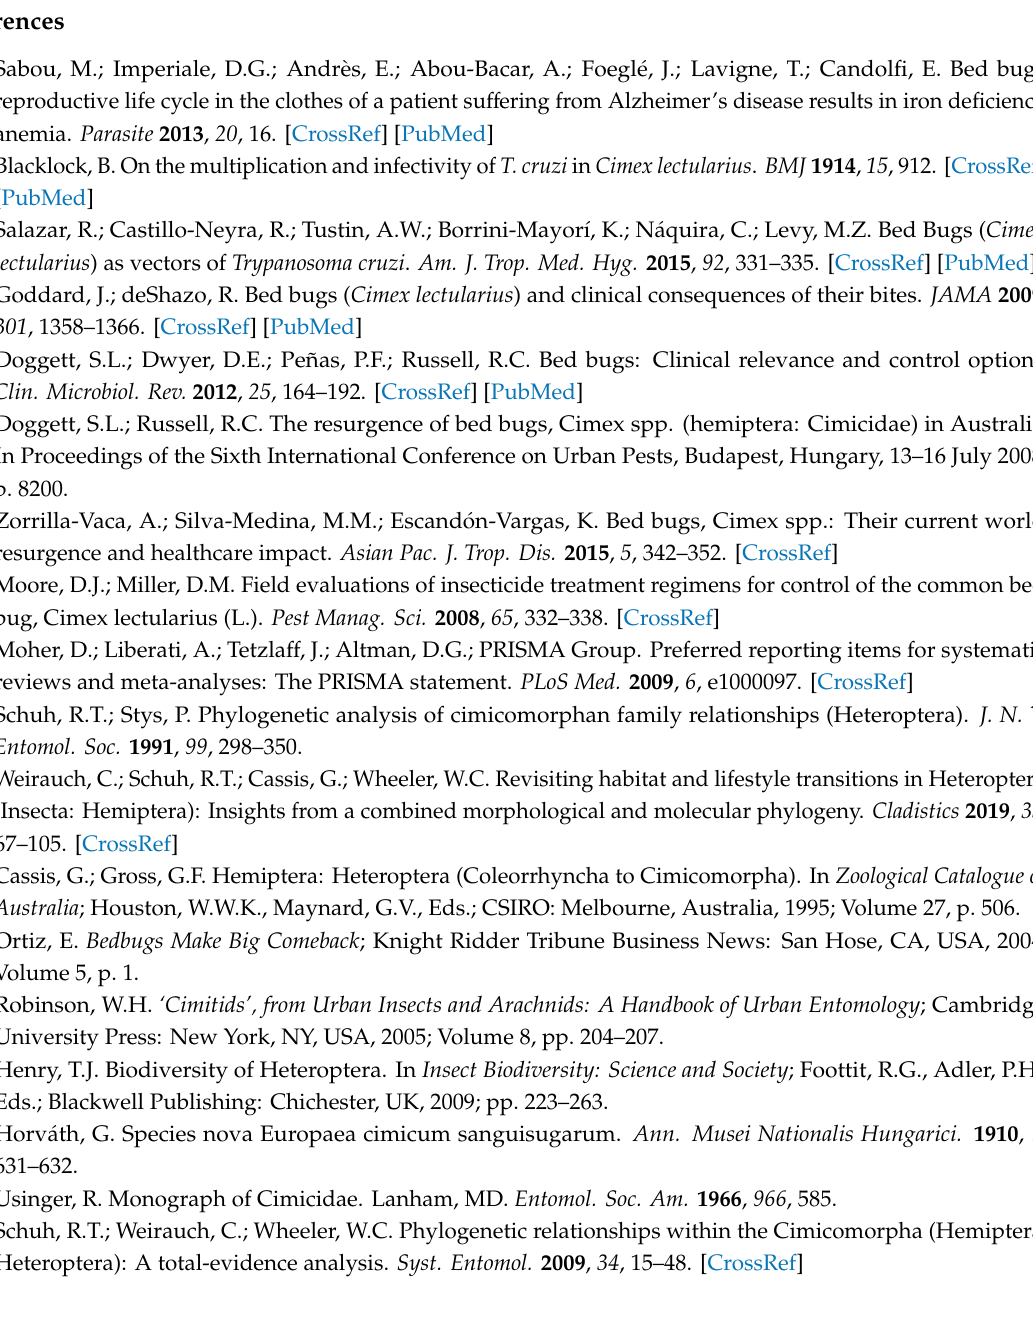
Table S1: Prisma checklist of article database investigated in the present study, Table S2: Worldwide dispersion of di ff erent Cimex species, present in di ff erent countries with their quoted